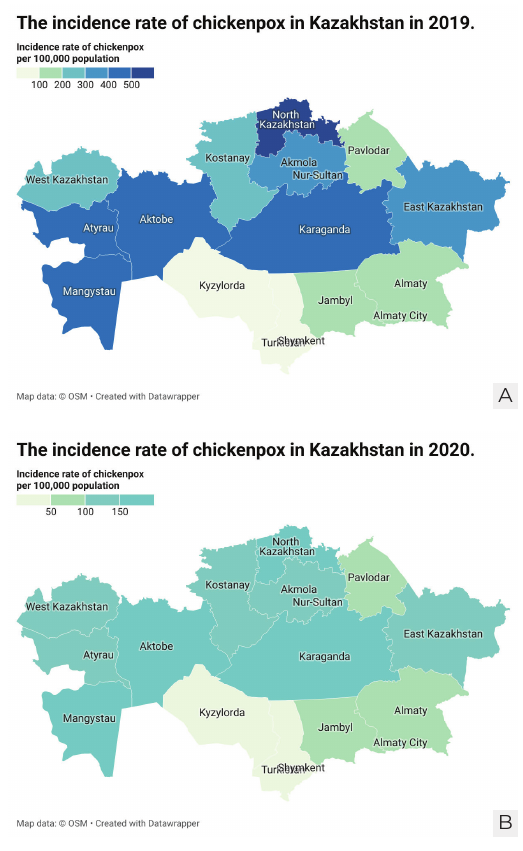
Figure 1 - The incidence rate of chickenpox in Kazakhstan in 2019 (A) and 2020 (B).